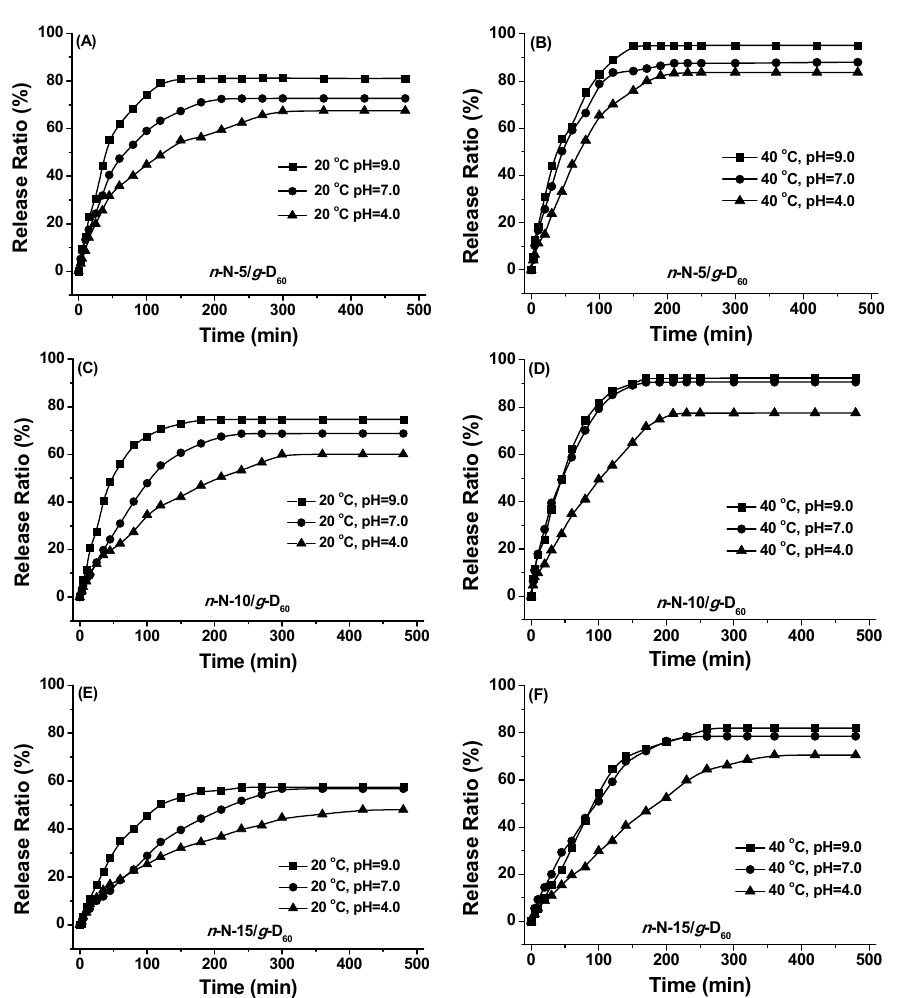
Figure 8. Drug release from n -N-5/ g -D 60 ( A and B ), n -N-10/ g -D 60 ( C and D ) and n -N-15/ g -D 60 ( E and F ) hydrogels under different temperatures and pHs.